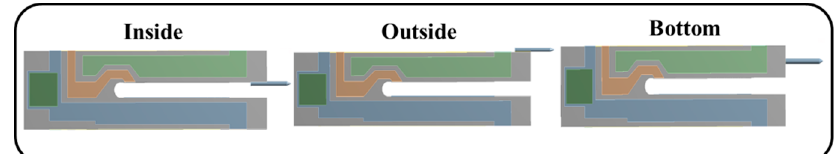
Figure 10. Three kinds of QTF-p configurations. Sensors 2018 , 18 , x